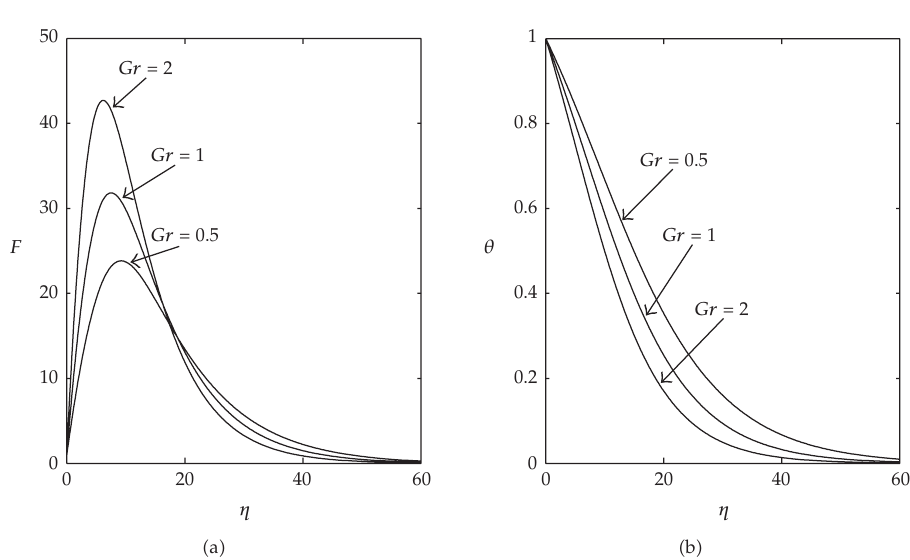
Figure 6: The variation of (cid:8) a (cid:9) velocity and (cid:8) b (cid:9) the temperature distribution with increasing Grashof number values with ξ (cid:7) 5 , Pr (cid:7) 0 . 72 , Sc (cid:7) 1 , V 0 (cid:7) 0 . 1 , R (cid:7) 1 .